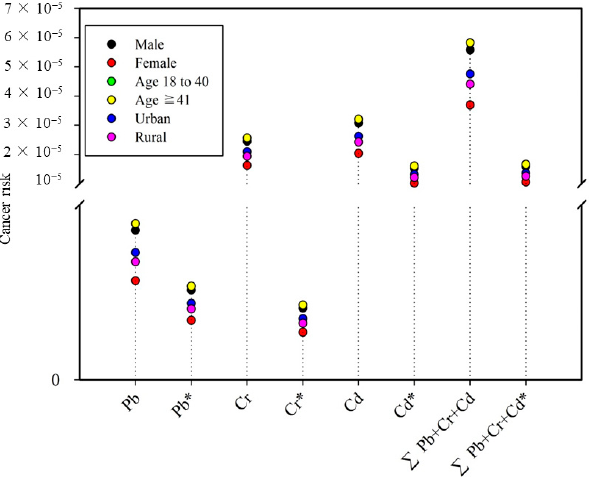
Figure 2. Cancer risk for different subpopulations due to drink tea infusion. Note: * means that the bioavailability of element was